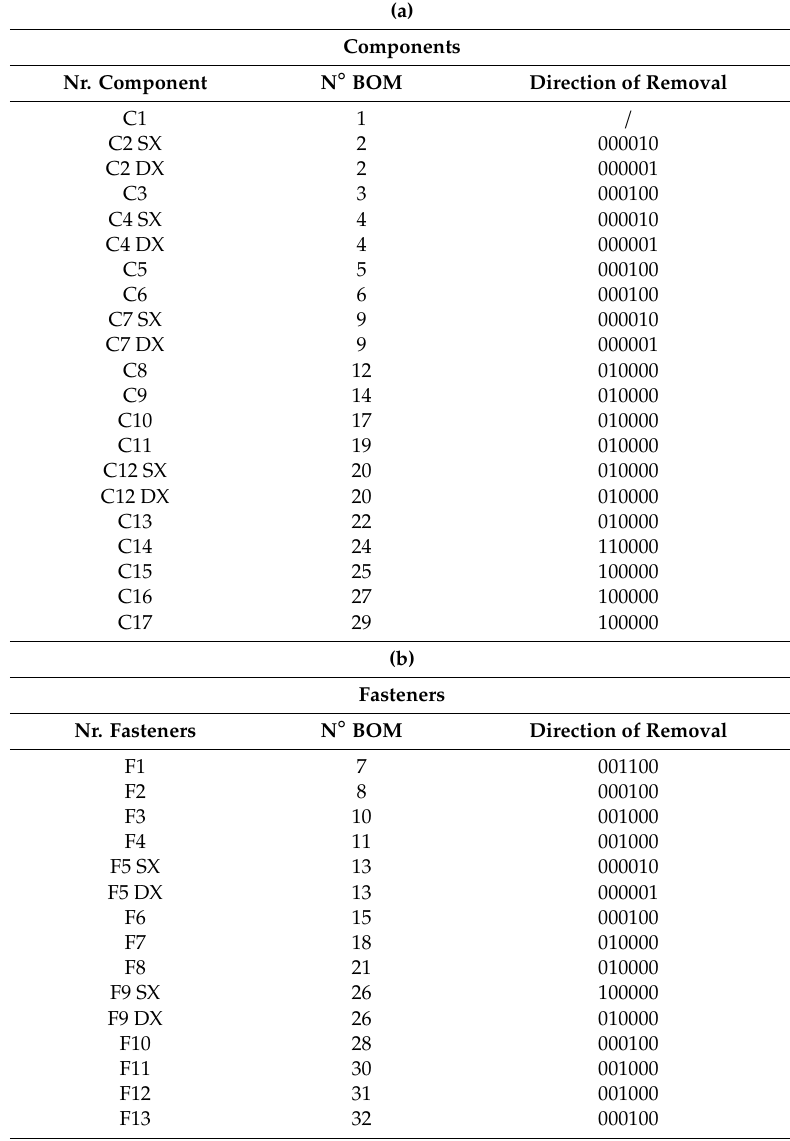
Table 3. ( a ) Components partition. ( b ) Fasteners